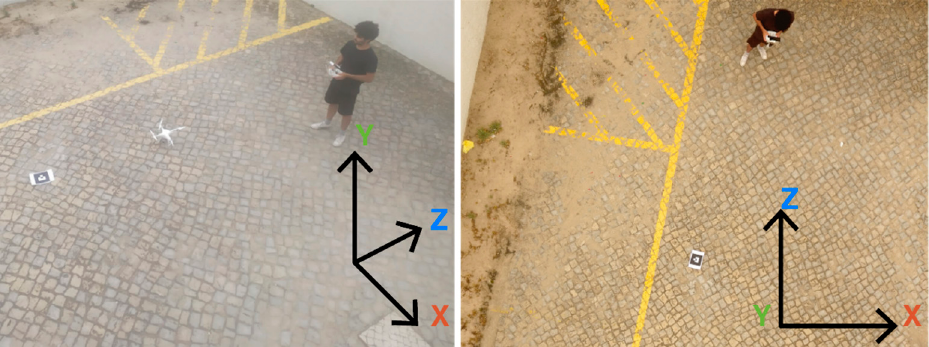
Figure 12. Test scenario of the pictures captured with a DJI Phantom 4 and an example of one of the pictures captured with a 7.5 m altitude.